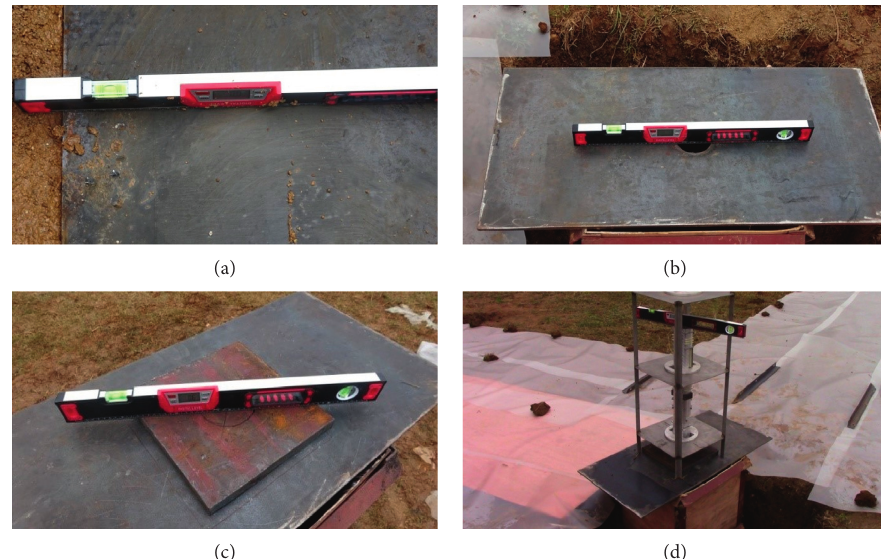
Figure 14: Level adjustment of the experimental platform: (a) level adjustment of the after-effect target plate of 10mm thick Q235 steel plate; (b) level adjustment of the experimental bench; (c) levelness of the 25 mm thick Q235 steel target plate adjustment; (d) the levelness adjustment of the simulated cabin.